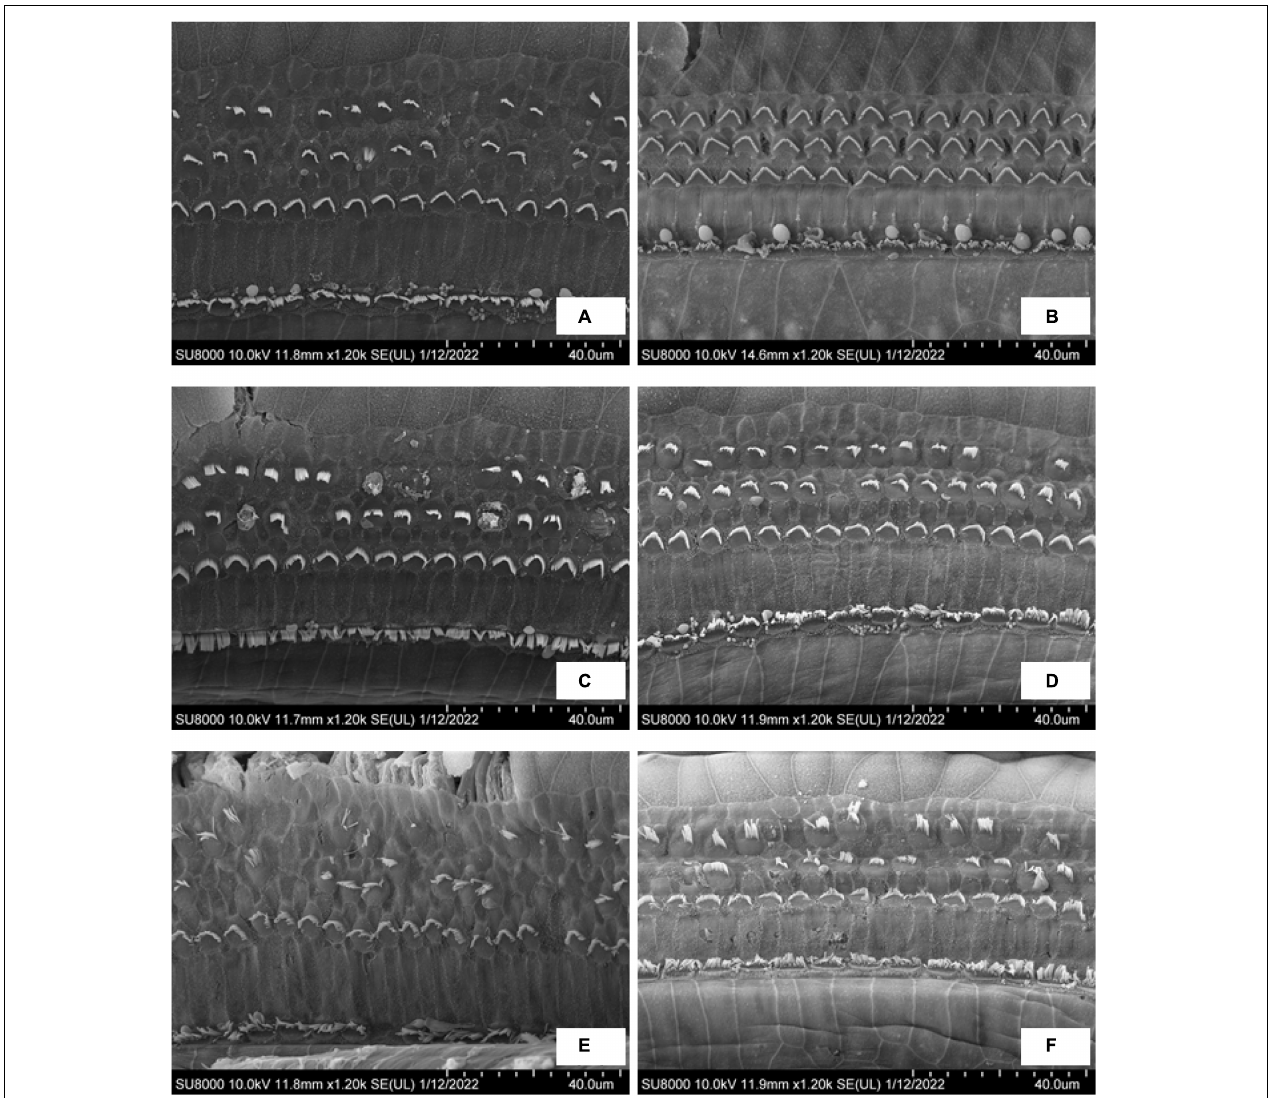
FIGURE 6 | The SEM observation of OHC in the EH 10-, 20-, and 30-day groups. (A,C,E) Turn 2 of the cochlea in the EH 10-, 20-, and 30-day groups. (B,D,F) Turn 3 of the cochlea in each group accordingly.